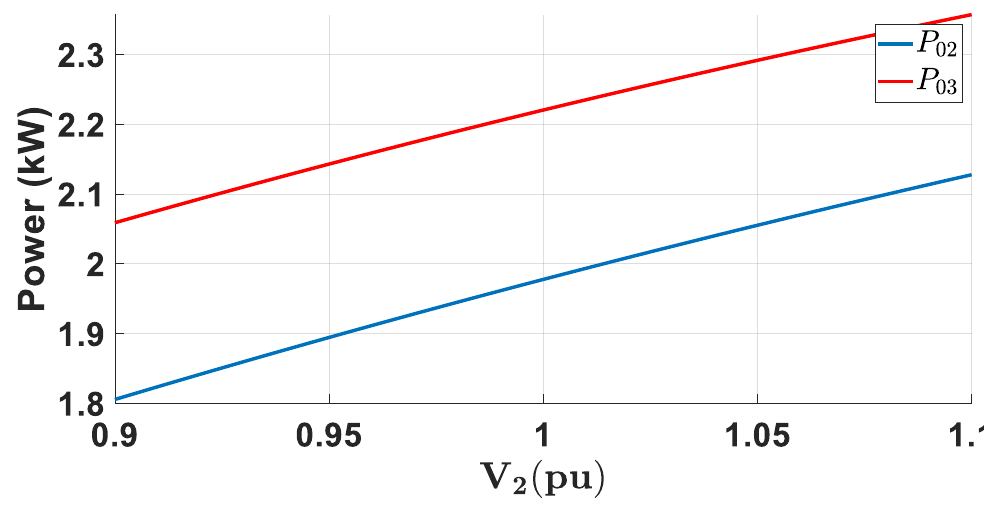
Figure 10. Sensitivity of 𝑃 02 and 𝑃 12 to 𝑉 2 .